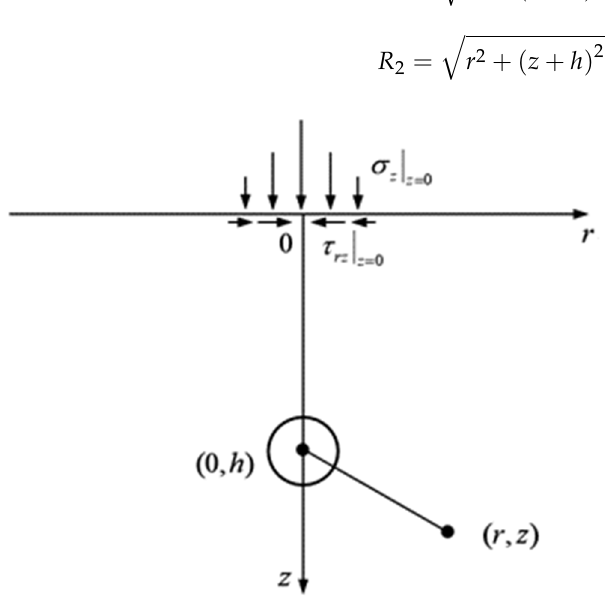
Figure 1. Stress boundary for semi-infinite cavity expansion correction. σ z is the vertical stress; r and z are the horizontal and vertical positions, respectively; τ r is the shear stress.